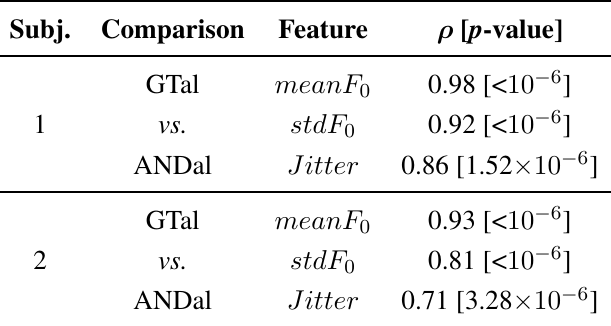
Table 4. HQmic, algorithms comparison: correlation coefficients regarding the features sets extracted from HQmic by using both ANDal and GTal. The corresponding p -values are shown in brackets.